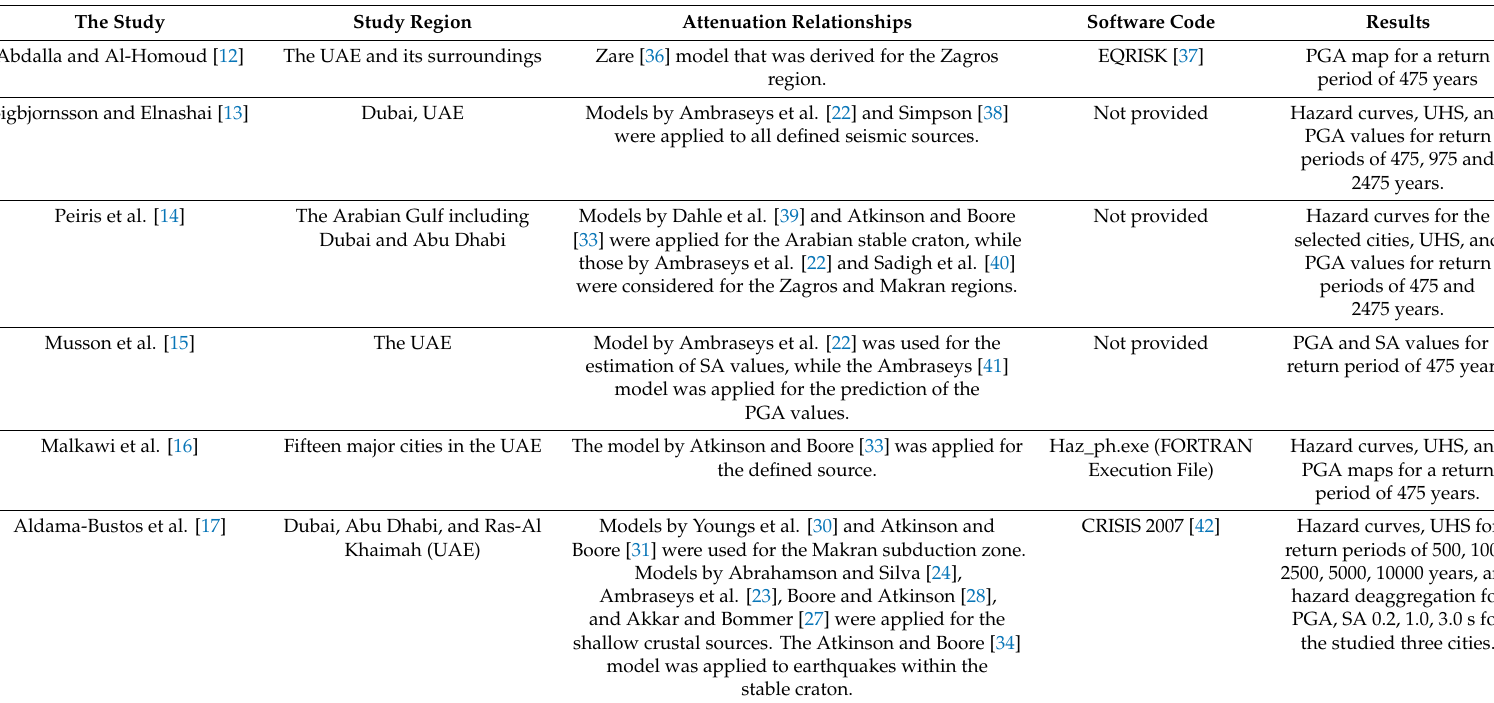
Table 1. Description of previously published regional and local PSHAs performed upon the study